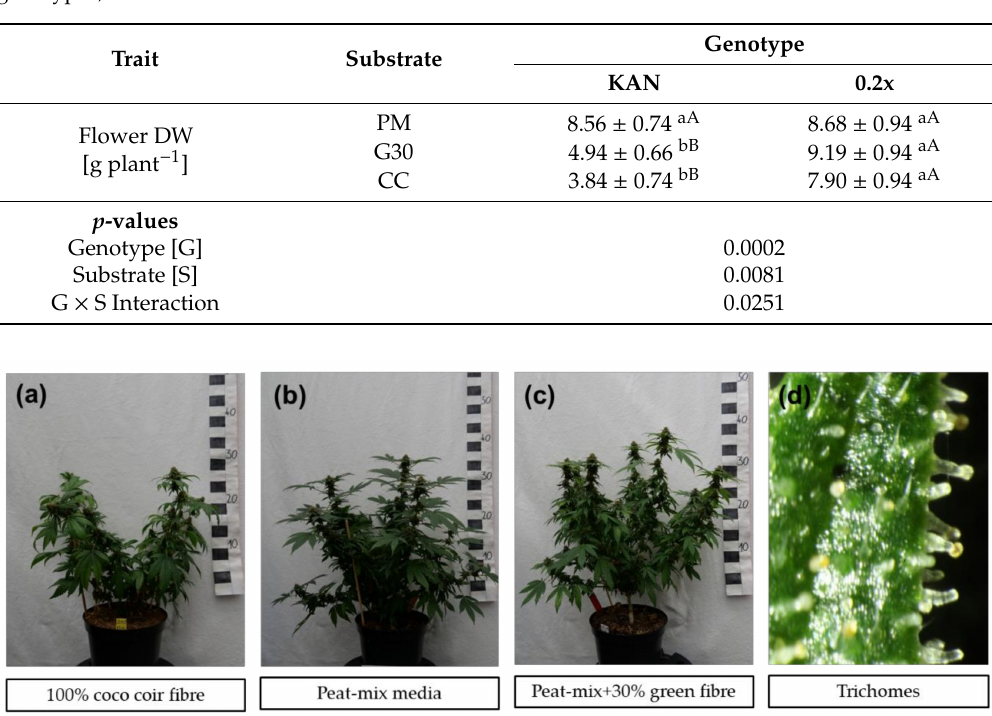
Figure 4. Plants of genotype 0.2x grown on ( a ) 100% coco coir fibre, ( b ) peat-mix media, ( c ) peat-mix + 30% green fibre media and ( d ) binocular imagine of a leaflet top of 0.2x 136 days after planting